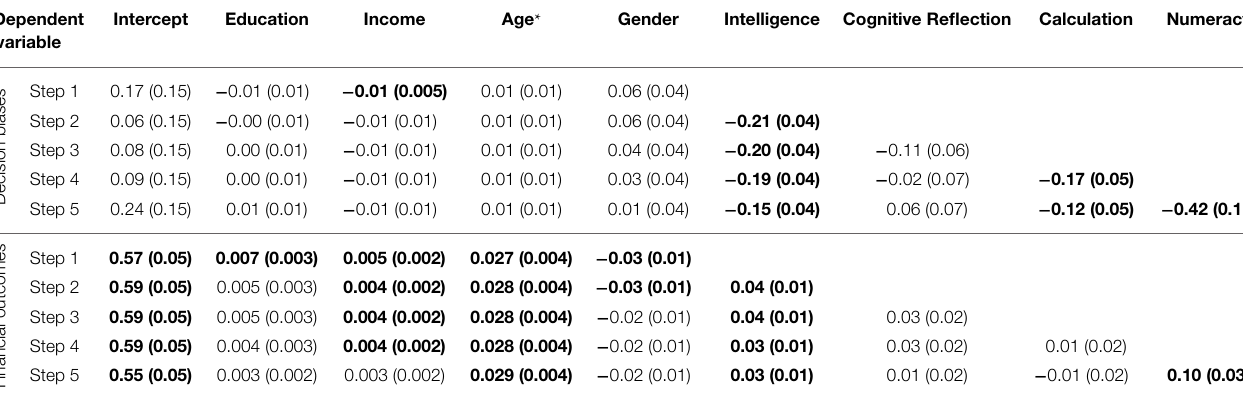
TABLE 8 | Stepwise regression results predicting decision-bias and financial-outcome composites in Study 2. Dependent